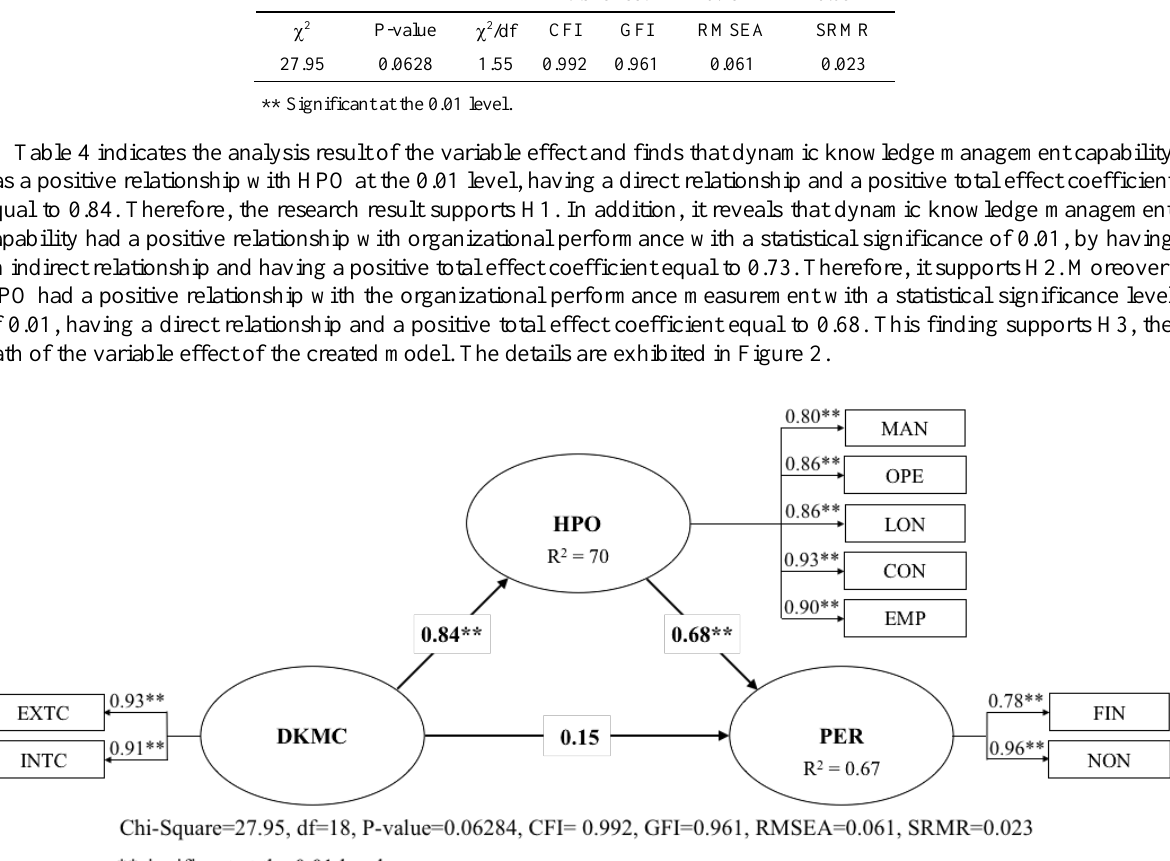
Figure 2. The structural equation